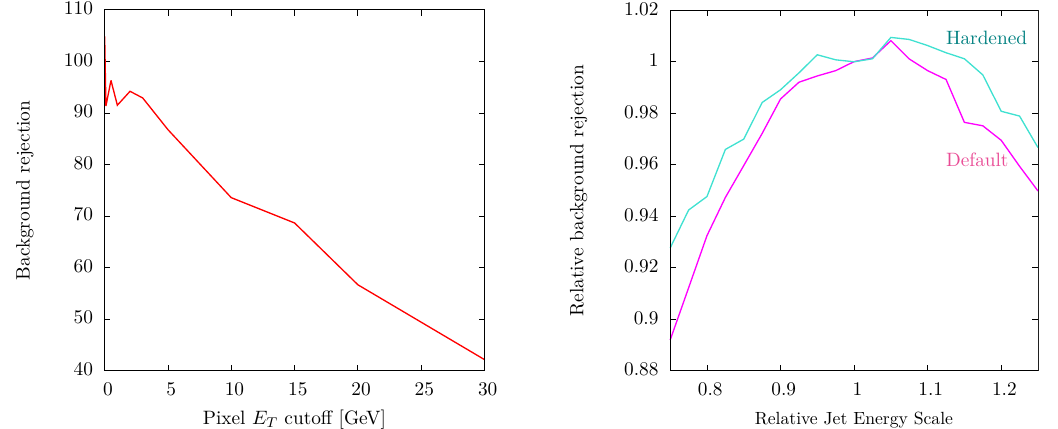
Figure 12 . Left: background rejection at a signal e(cid:14)ciency of 30 % for di(cid:11)erent activation thresh- olds. Right: background rejection for the default and hardened training for di(cid:11)erent re-scalings of the jet images. The background rejection is evaluated at a signal e(cid:14)ciency of 30 % and normalized to the rejection at nominal